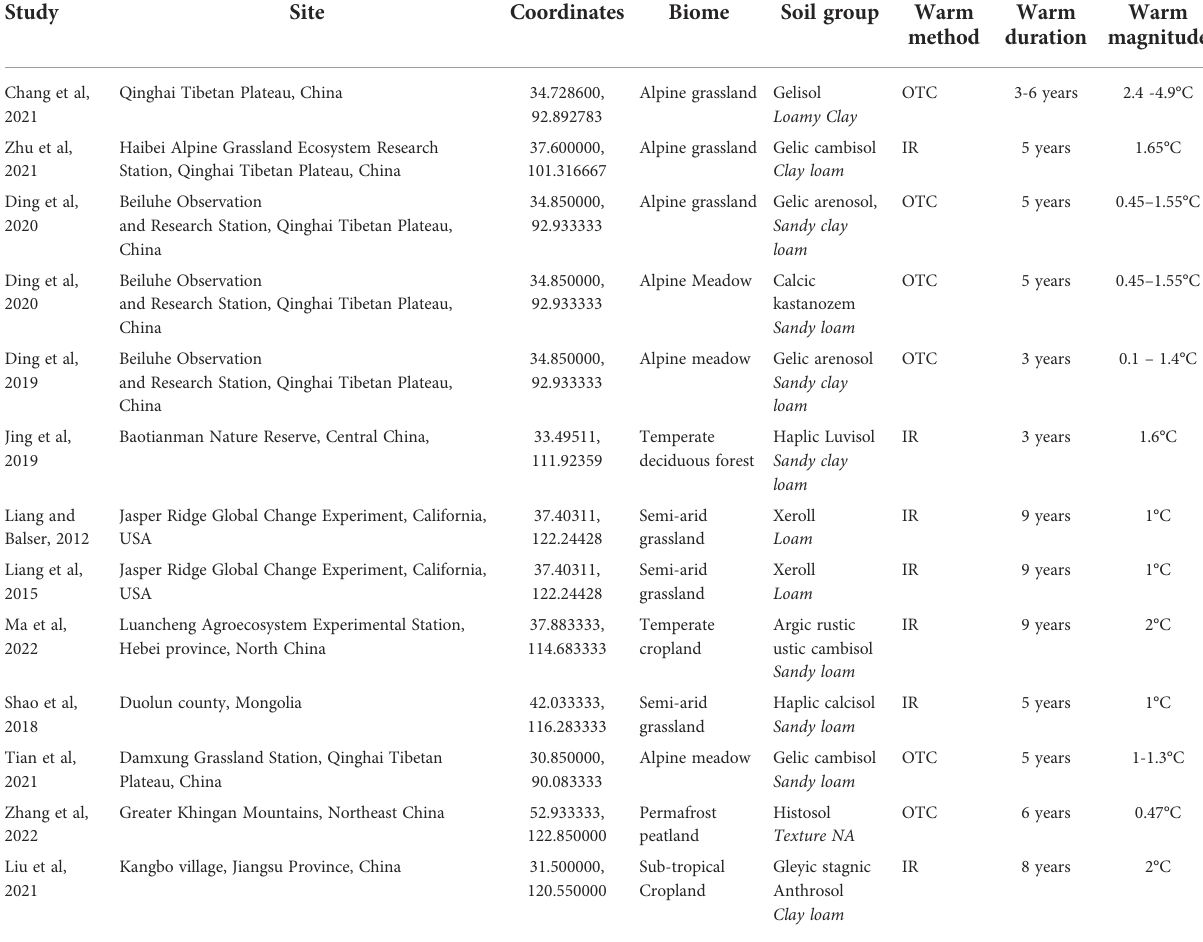
TABLE 1 Soil warming experiment publications and associated geographic and climatic data that were included in this meta-analysis.